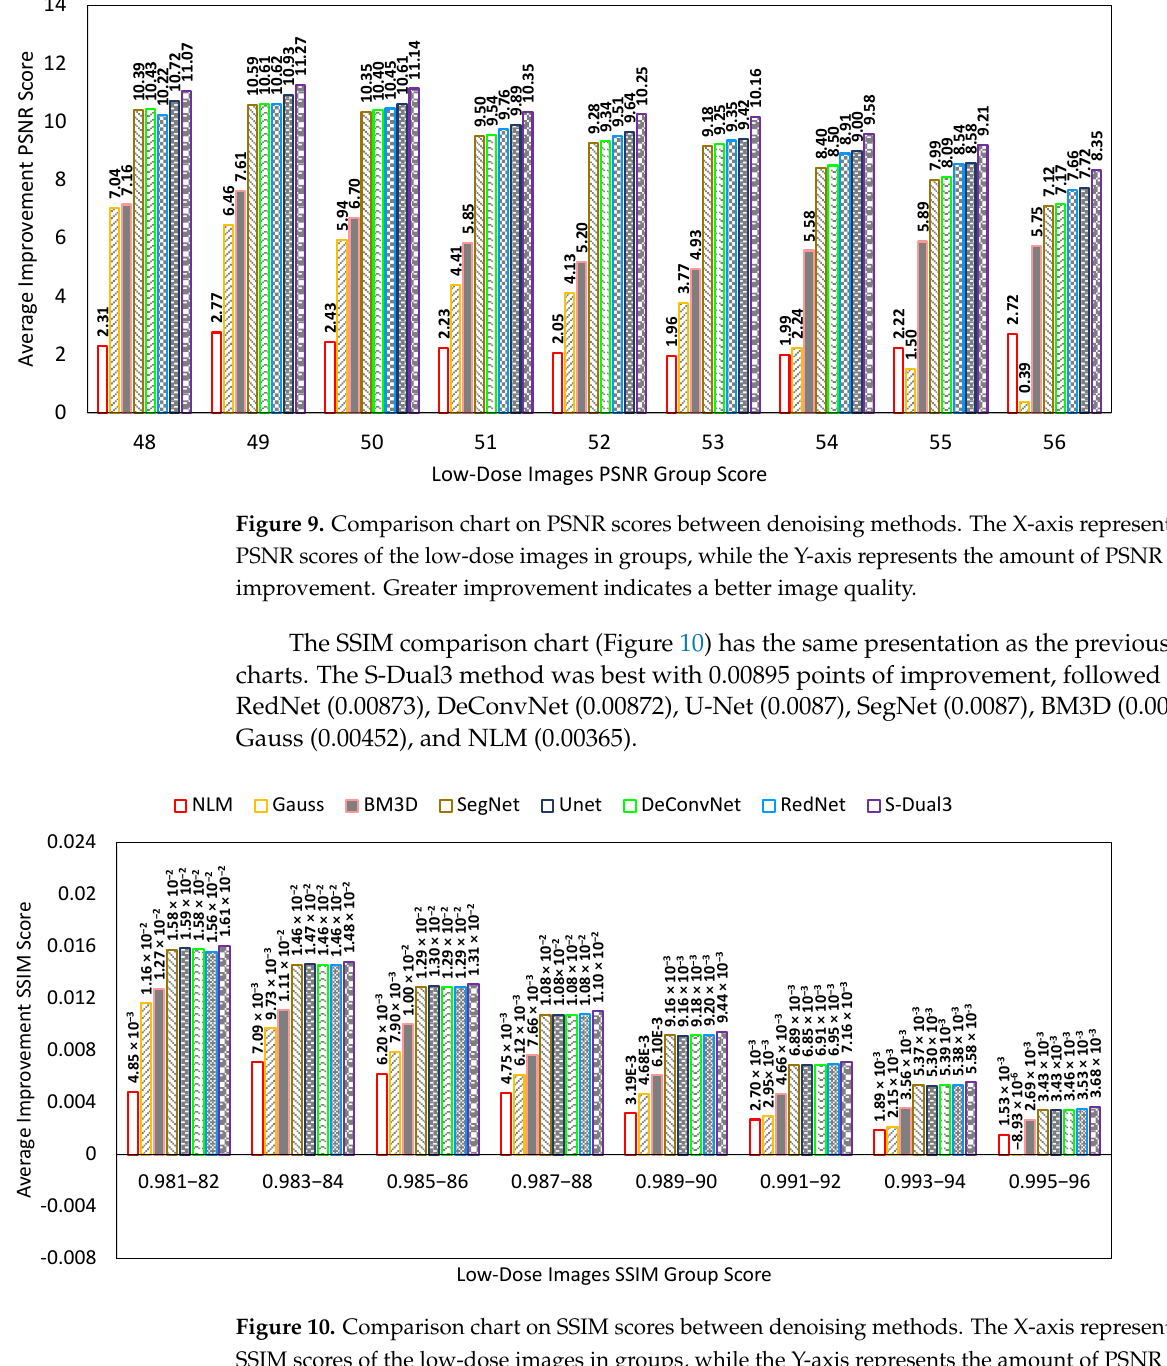
and bar arrangement follows the same configuration of low (left) to high (right) as the NIQE chart. The S-Dual3 method was best with 10.55 points of improvement, followed by U-Net (10.01), RedNet (9.85), DeConvNet (9.72), SegNet (9.67), BM3D (6.33), Gauss (4.77), and NLM (2.28).